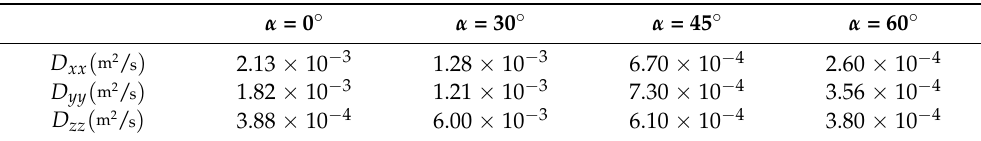
Table 1. Diffusion coefficient calculated for various paddle angles (for 30 s simulation of 40% fill level and 40